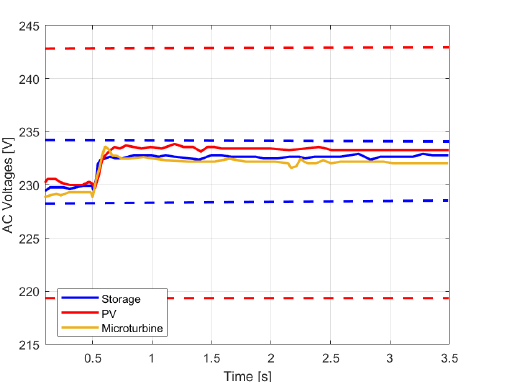
Figure 14. Simulation C: AC Voltages. The blue dashed lines represent V ac , ST , max and V ac , ST , min , while the red dashed lines represent V ac , PV , max and V ac , PV , min .